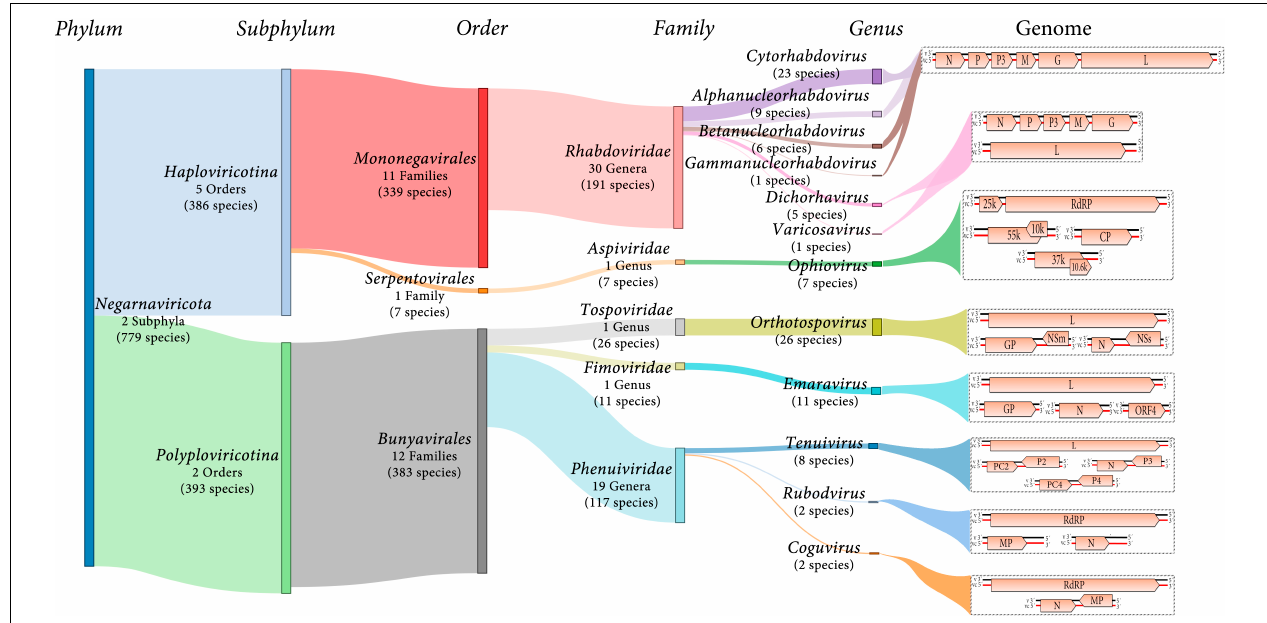
FIGURE 1 | Diagram showing an overview of plant NSR virus taxonomy and schematic genome graphs depicting organization and gene products of representative members of each taxon. The predicted coding sequences are shown in orange arrowed boxes, virion-sense RNA (v) is depicted in black, while virion-complementary sense RNA (vc) is depicted in red. The number of taxonomic categories included in each taxon are indicated. Species number indicate 2019 ICTV-accepted virus species corresponding to each taxonomic rank.